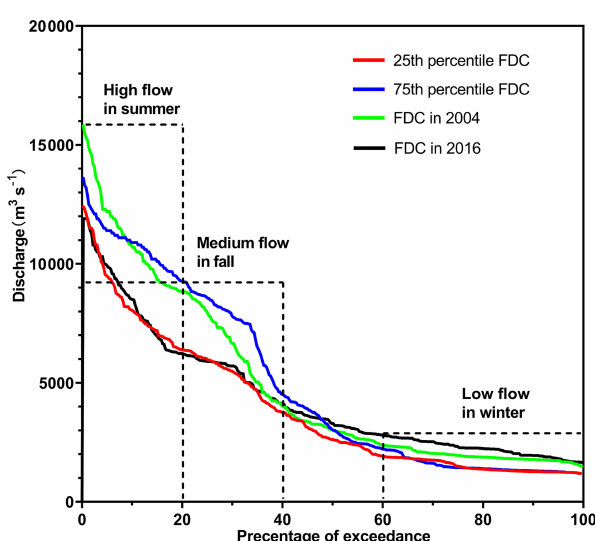
Figure 6. Annual flow duration curves in 2004 and 2016 in Panzhi- hua